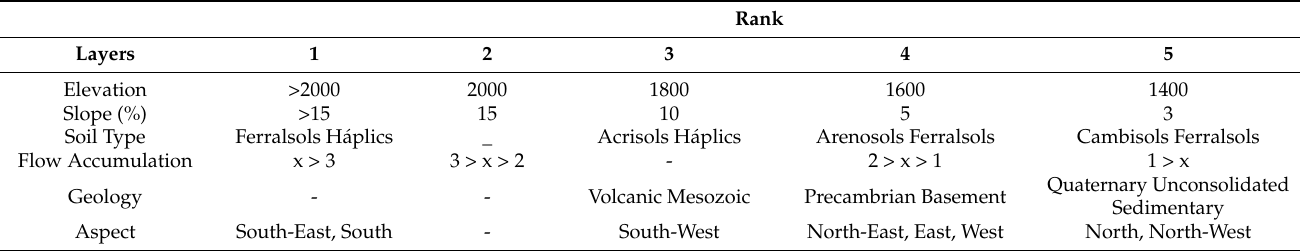
Table 1. Rating summary table for all the used criteria.